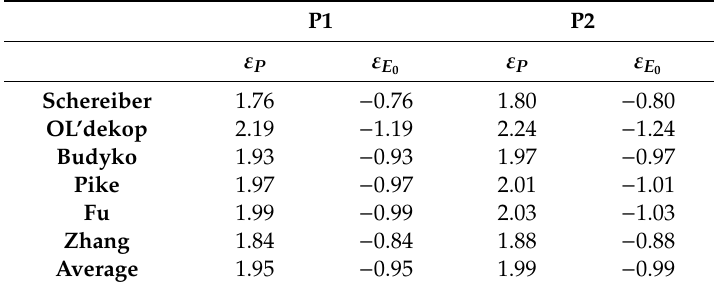
Table 4. Precipitation elasticity for runo ff and potential elasticity for runo ff